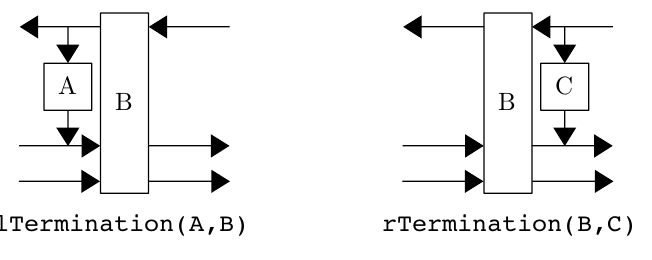
Figure 15. lTermination(A,B) and rTermination(B,C) in the F AUST Physical Modeling